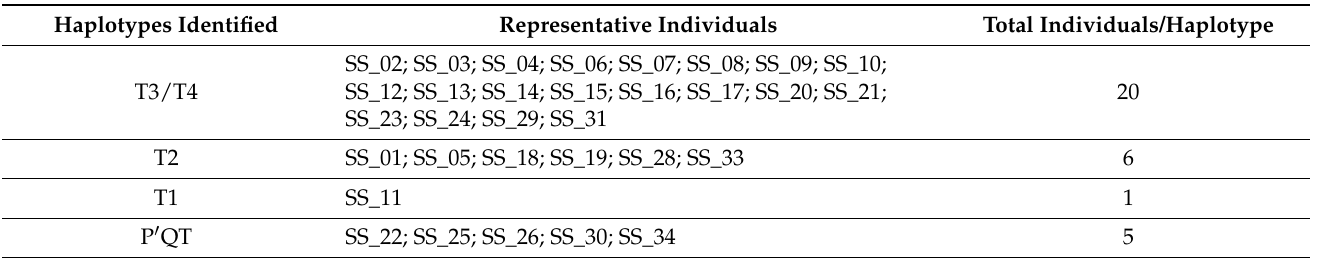
Table 7. Identified haplotypes and representative individuals for each haplotype in Grey Steppe population.